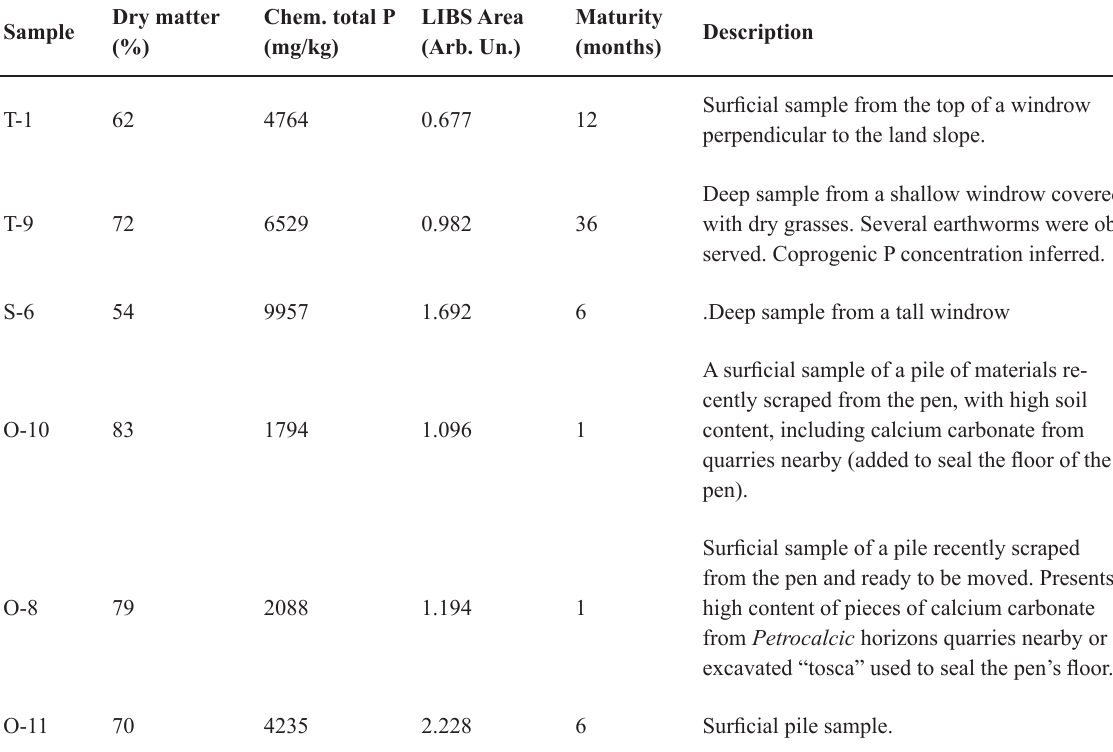
Table 3 Description of the outlier